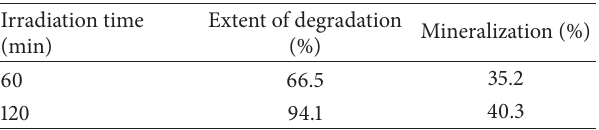
Table 2: Degradation and mineralization percentages after ultra- sonic irradiation (initial dye concentration = 10 𝜇 molL −1 , ultrasonic power = 400W, ultrasonic frequency = 25kHz, temperature = 22 ∘ C, and pH =